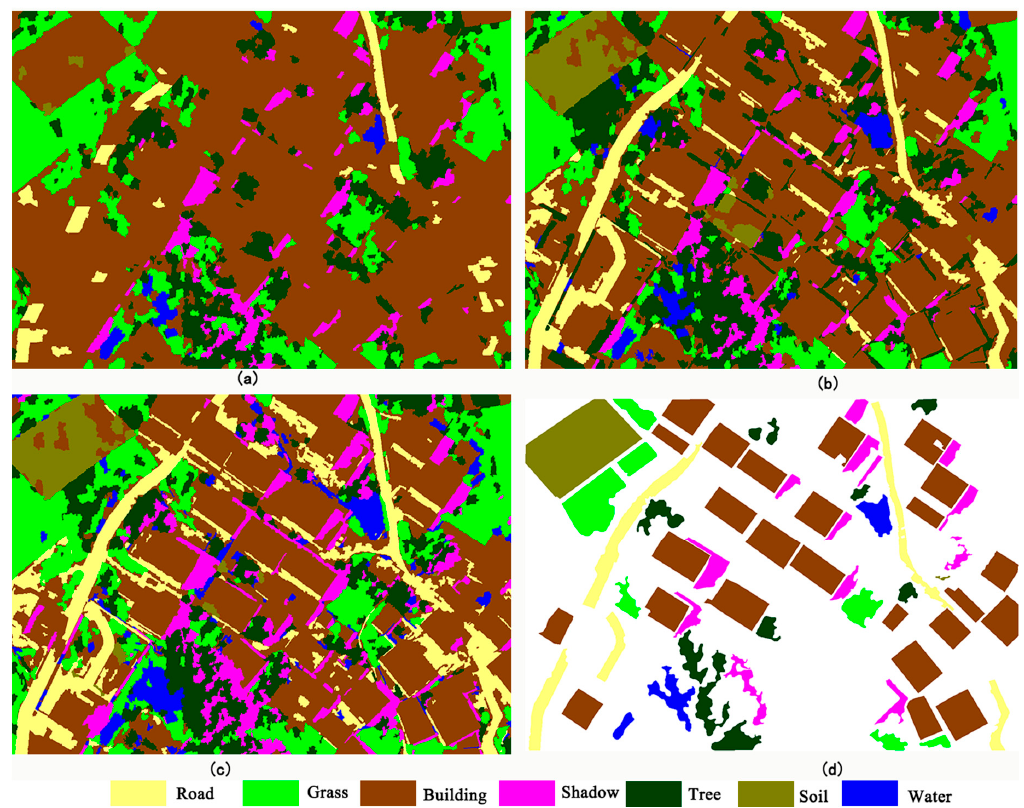
Figure 6. Classification maps based proposed spatial-spectral feature method using different classifiers: ( a ) map obtained by maximum likelihood classifier (MLC) ( b ) map obtained by naive Bayes classifier (NBC); ( c ) map obtained by support vector machine (SVM); ( d ) the ground reference. Table 6. Class-specific accuracies (%) for features in SVM classification of aerial image data.